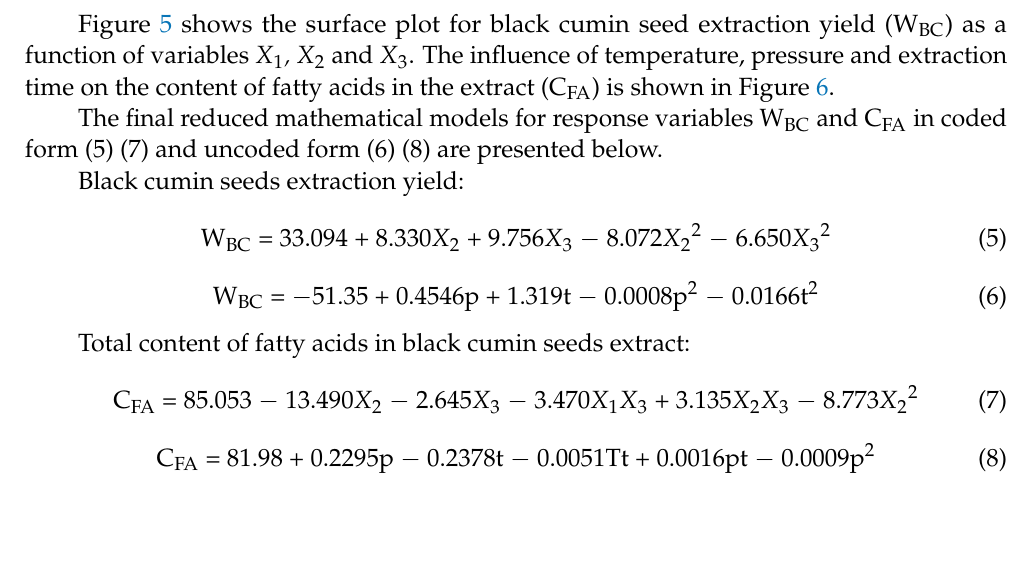
Figure 4. Comparison of the experimental results with the results predicted according to the developed mathematical models: ( a ) for extraction yield (y = 0.9300x + 1.7679), ( b ) for the content of fatty acids in the black cumin seed extract (y = 0.9541x + 3.6855).